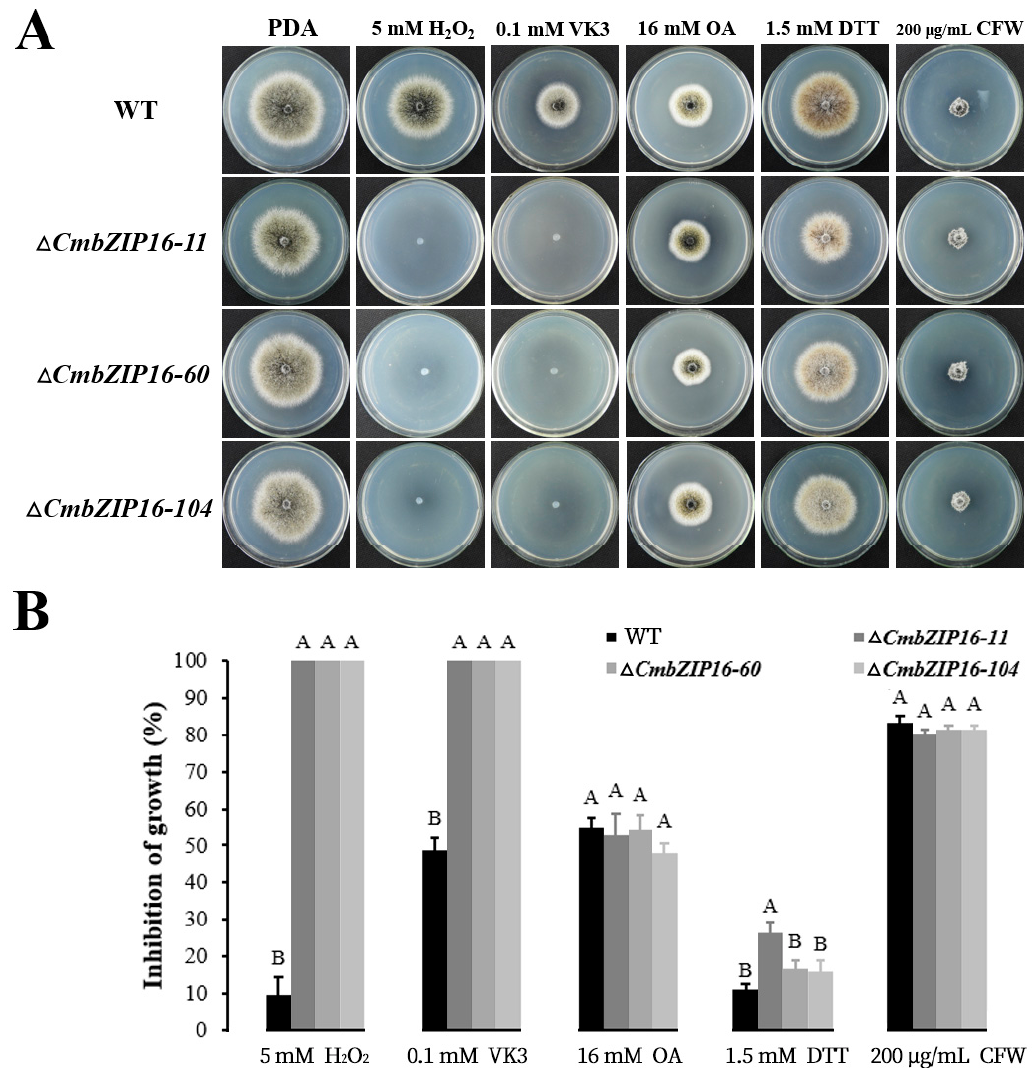
Figure 9. Sensitivity of Δ CmbZIP16 mutants to abiotic stresses. ( A ) Morphology of wild type and Δ CmbZIP16 mutants on PDA media with abiotic stresses ( 5 mmol L − 1 H 2 O 2 , 0.1 mmol L − 1 VK3, 16 mmol L − 1 OA, 1.5 mmol L − 1 DTT, and 200 μ g mL − 1 CFW ), at 10 days after inoculation. ( B ) Inhibition of growth on PDA was examined under several separate stress factors. Values are means of three independent replicates and bars represent the standard deviation. Statistical analyses were performed using the one-way ANOVA method at the 99% significance level. PDA, potato dextrose agar; H 2 O 2 , hydrogen peroxide; VK3, vitamin K3; OA, oxalic acid; DTT, dithiothreitol; CFW, calcofluor white.